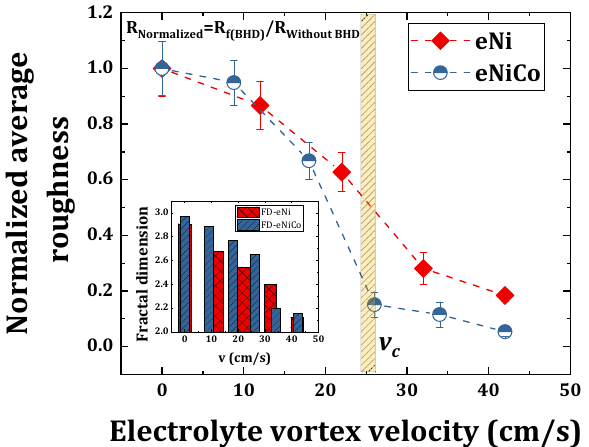
Figure 8. Average roughness values measured from the AFM micrographs for eNi and eNiCo alloy coating samples as a function of BHD with varying vortex velocities, electrodeposited at j = 50 mA/cm 2 , bath pH value = 4, bath temperature = 45 ◦ C, and cathode position at x = 40 mm from vortex core. Deposition duration 15 min and 60 min for eNiCo coatings and eNi, respectively. Dotted line is shown to distinguish the data points. Absolute R a and FD values are listed in Table